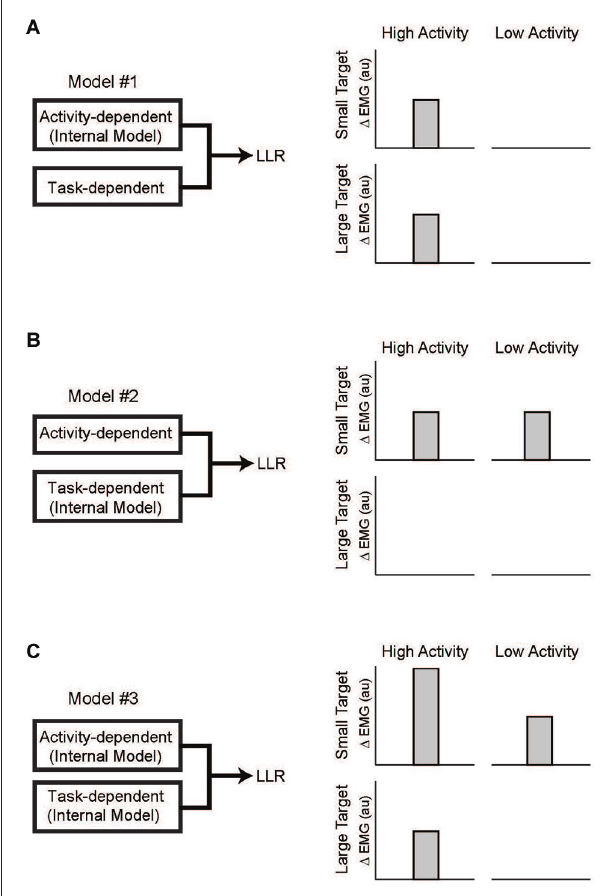
FIGURE 7 | Testing which component of the LLR utilizes knowledge of limb dynamics. (A) Left panel depicts a simple model of LLR comprised of two functional component: an automatic component scaled by background muscle activity and a task-dependent component scaled by target size. Right panel depicts expected pattern of LLR if only the automatic component utilized an internal model of limb dynamics. Expression of that information (i.e., a differential response to the pair of perturbations) would be evident during high background activity of the muscle but would not change with target size. (B) If only the task-dependent component utilized an internal model of limb dynamics than expression of that information would be evident with a small target requiring a vigorous response and not change with background activity of the muscle. (C) If both the automatic and task-dependent components utilized an internal model of limb dynamics than expression of that information would co-vary with background activity and target size. Figure modified with permission from Kurtzer et al.